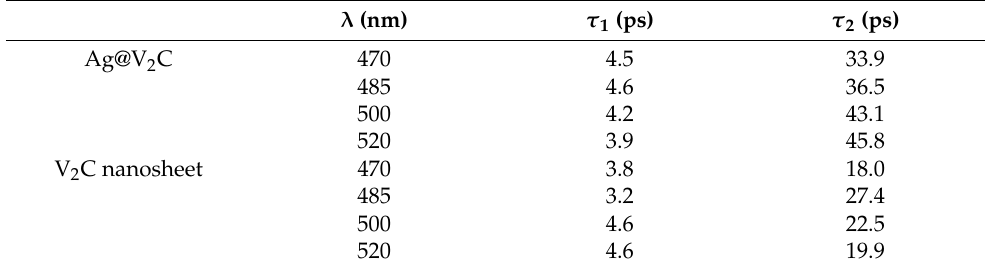
Table 2. Carrier dynamics parameters of the Ag@V 2 C nanosheet.